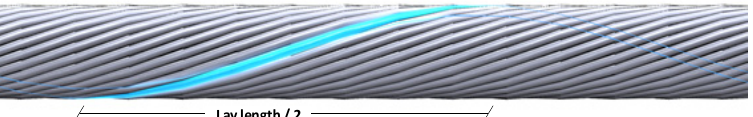
Figure 1. Stranded conductor and lay length.